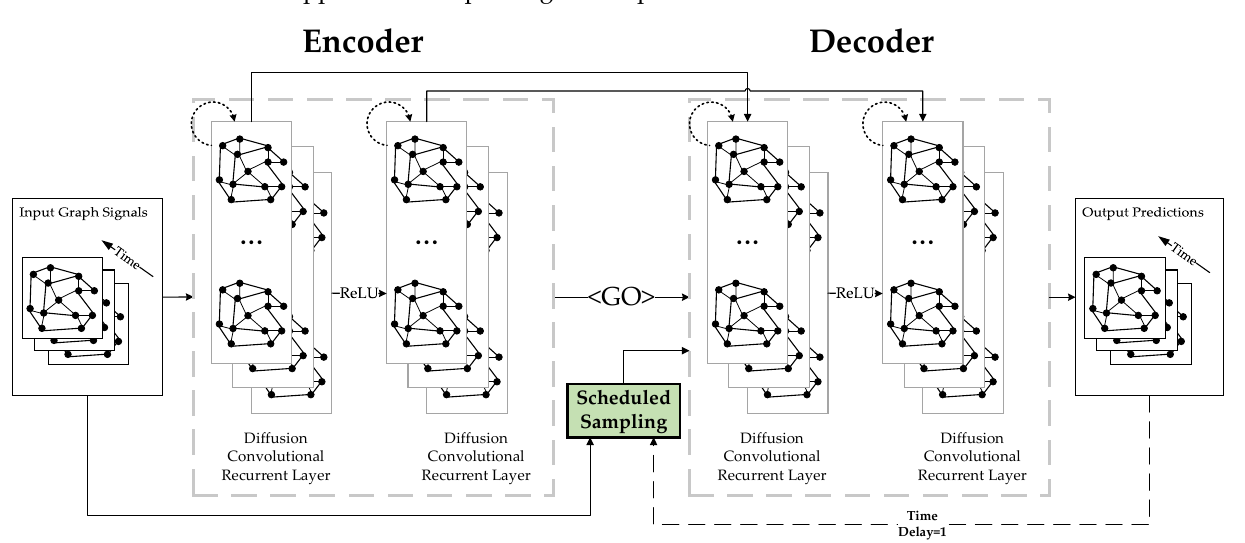
Figure 2. The architecture for the DCRNN for bus passenger flow prediction.